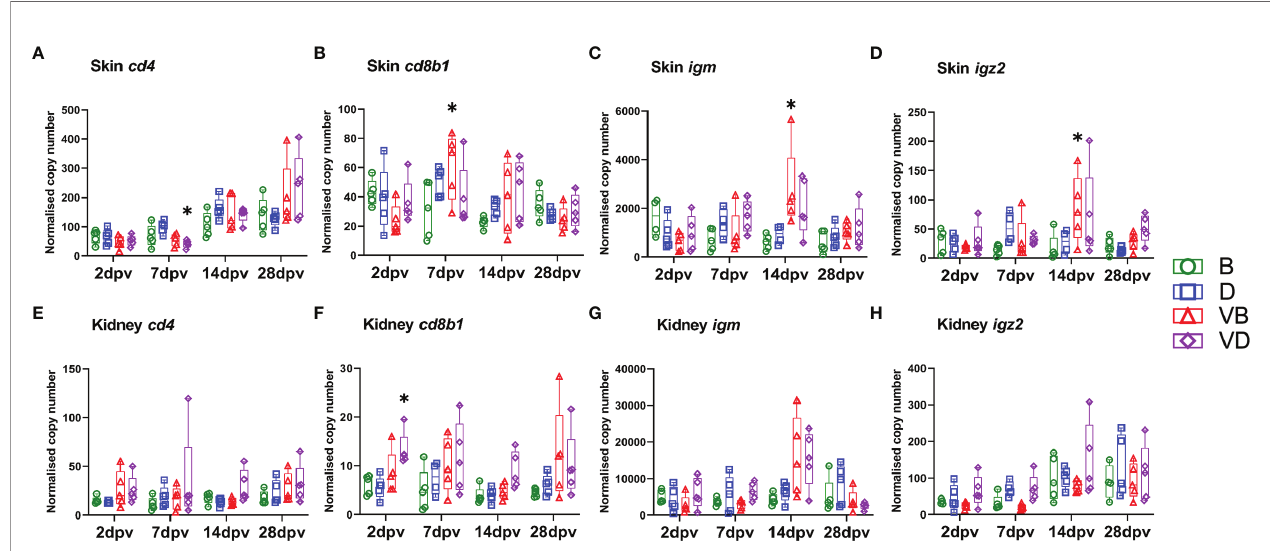
FIGURE 3 | Levels of transcripts coding for proteins involved in immune responses to vaccination with KHV-T D DUT/TK, measured with RT-qPCR in skin: (A) cd4 , (B) cd8b1 , (C) igm , (D) igz2 , and kidney: (E) cd4 , (F) cd8b1 , (G) igm , (H) igz2 . The description of experimental groups: B – BSA non-vaccinated, D – defensins non- vaccinated, VB - BSA vaccinated, VD – defensins vaccinated. The results are presented as 25%-75% box plots with min. and max. values as whiskers with indication of all data points. The data are shown as normalised copy numbers. * indicates statistical signi fi cant difference to non-vaccinated control at p < 0.05. Statistical analysis was performed with two-way ANOVA with multiple comparisons test performed with the Holm-Sidak method.